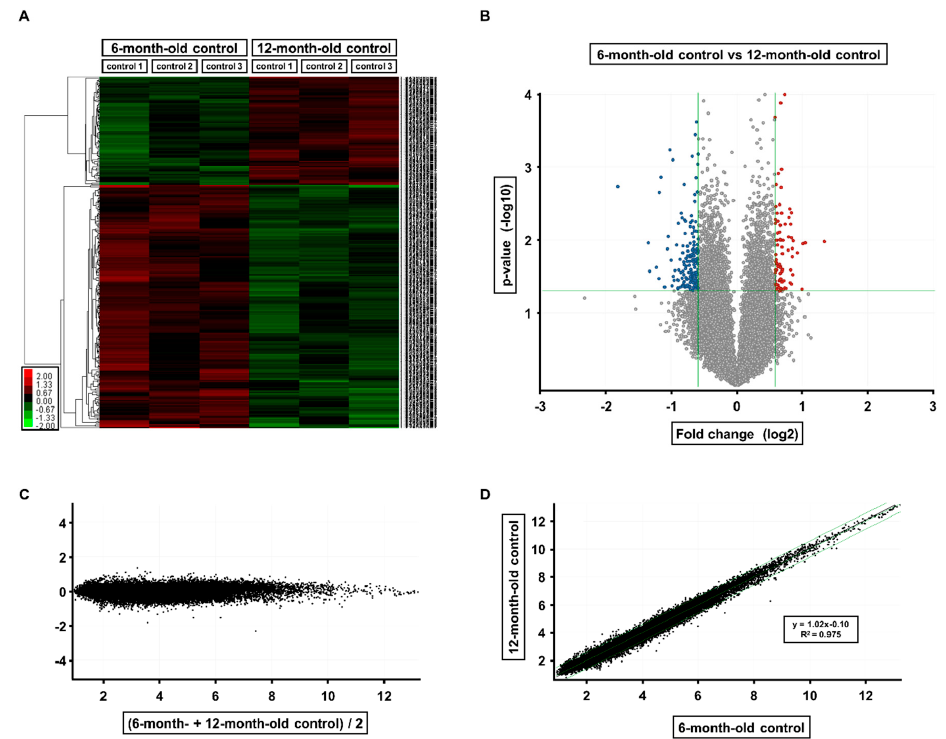
Figure 2. Gene expression in ovaries from 6-month-old and 12-month-old C57BL/6 mice: ( A ) hierarchical clustering and heat map analysis. A heat map of significantly differentially expressed (>1.5-fold) genes is shown. Red dots represent higher expression and green dots represent lower expression at 12 months of age. Volcano plot ( B ) and scatter plots ( C , D ) of the microarray analysis data.